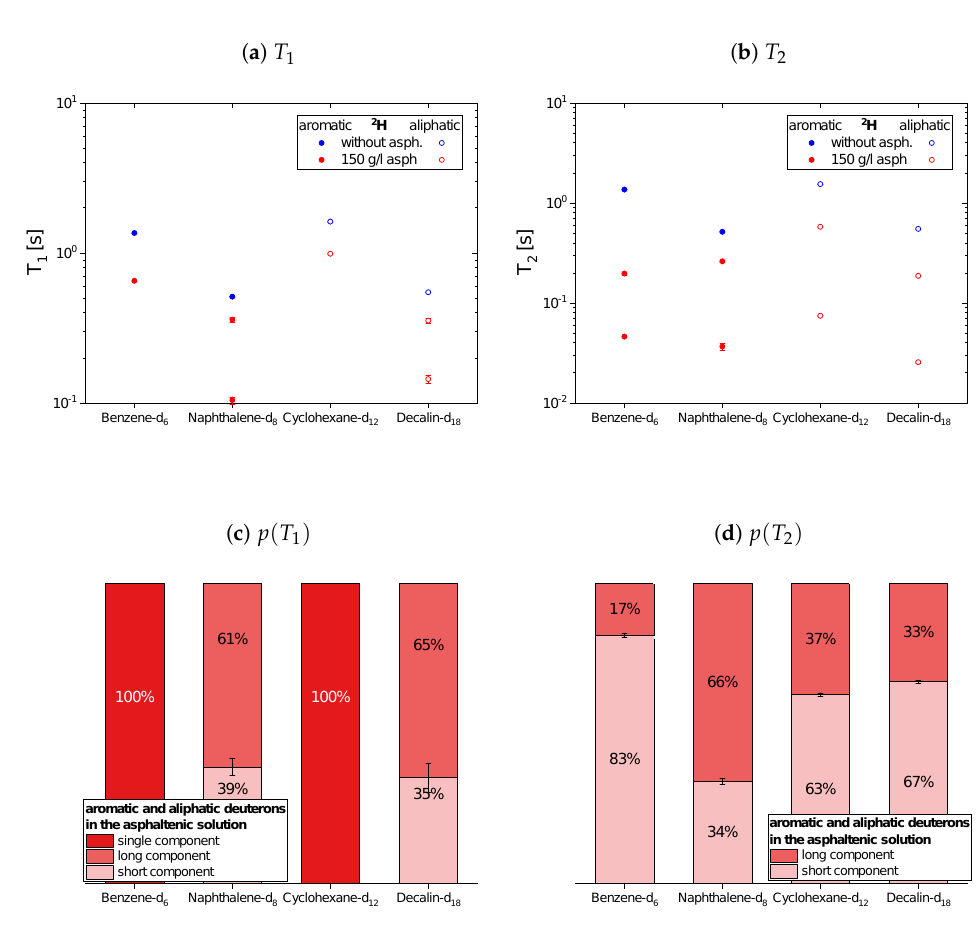
Figure 12. Top: Longitudinal ( a ) and transverse ( b ) relaxation time constants of the aromatic and aliphatic deuterons of cyclic maltenes in the asphaltene-free and the asphaltenic solution. Bottom: Relative weight of the T 1 ( c ) and T 2 ( d ) components of the maltenes’ deuterons in the asphaltenic solution. The x-axis distinguishes the different solutions, consisting of 5vol% of the specified maltene and 95vol% benzene without or with 150g/L